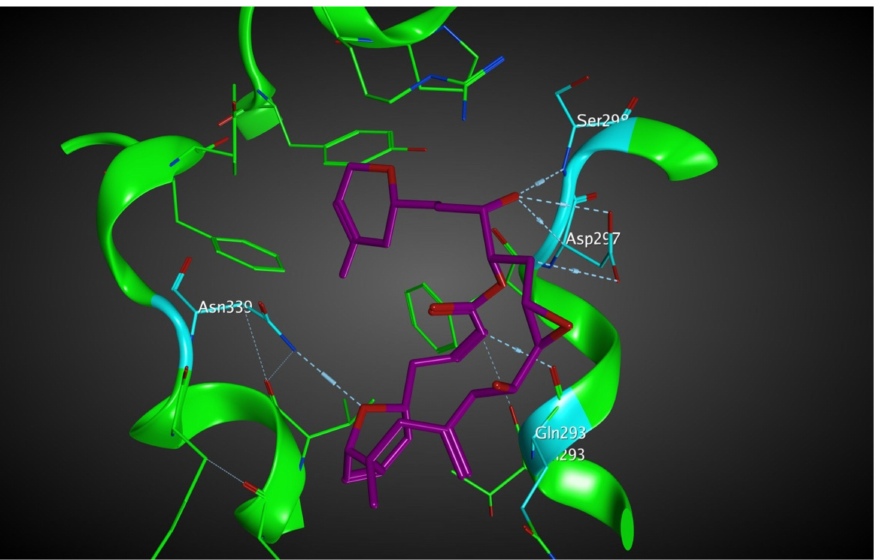
Figure 10. Laulimalide in the laulimalide binding site of β tubulin (green) based on the 4O4H PDB file. The residues in blue are involved hydrogen bond interaction with laulimalide